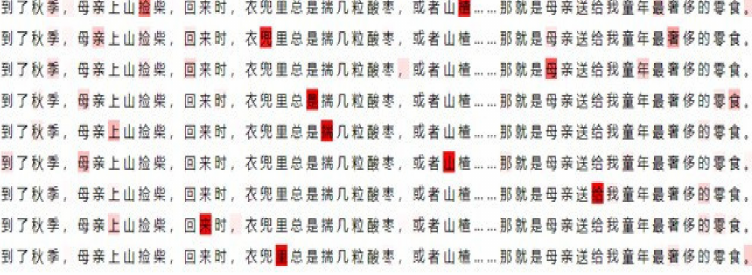
Figure 10. Instance of attention matrix visualization 1.